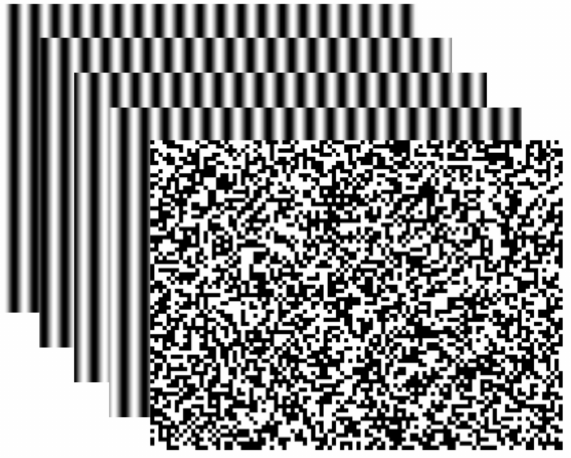
Figure 5. Projected image patterns.